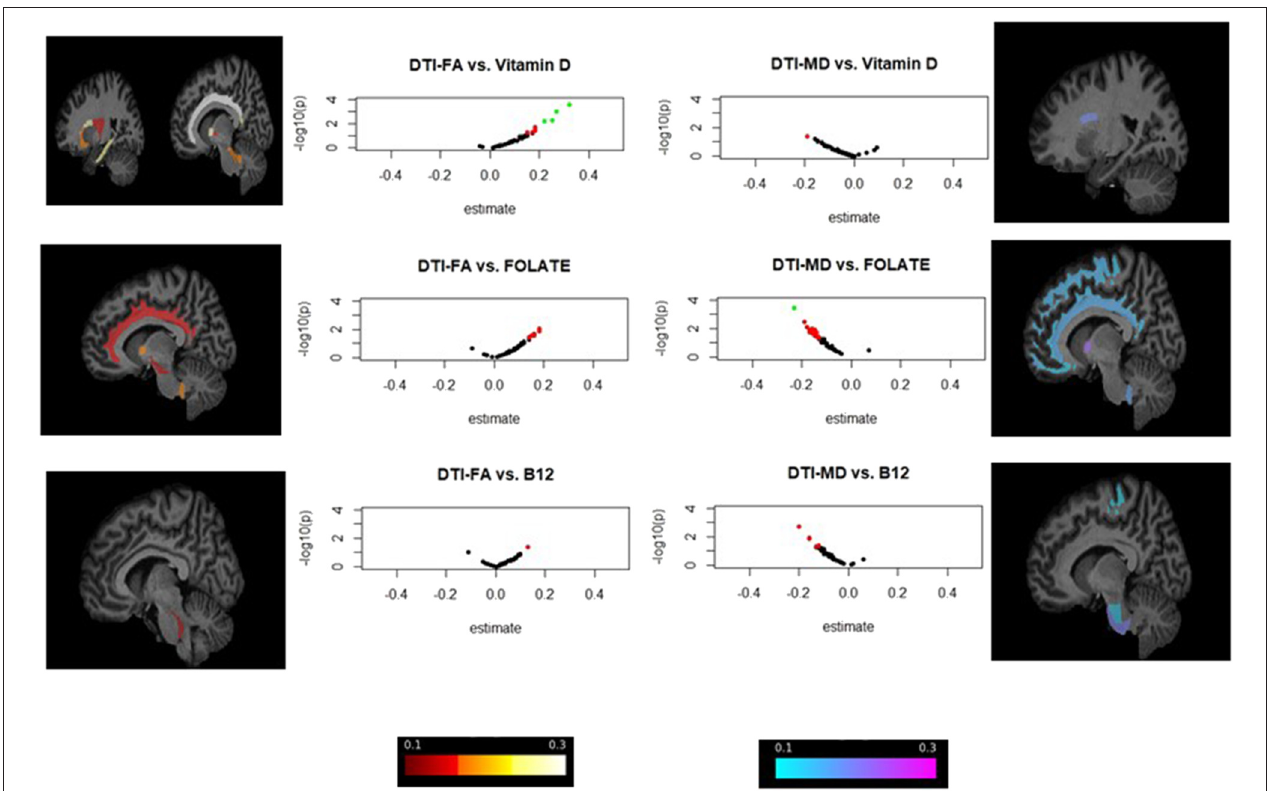
FIGURE 2 | ROI-wide brain dMRI association with v 1 serum 25(OH)D, folate and cobalamin in total population: volcano plots and brain image visualization for HANDLS 2004–2009 and HANDLS-SCAN 2011–2015 a,b . a Volcano plots display Log 10 ( p -values) for each set of models against the standardized effect (b) on the X-axis, highlighting findings with larger effect sizes. Associations with P < 0.05 are presented in red, whereas those with both P < 0.05 and effect size in absolute value > 0.20 are presented in green. b Brain visualization using FSLeyes program is focused on standardized effect sizes (b) and direction, with negative effects ( b < 0) shown in cold colors and positive effects ( b > 0) shown in warmer colors. The range is between − 0.3 and + 0.3 with lighter colors indicating stronger effects in either direction. Only ROIs with uncorrected p -value < 0.05 are